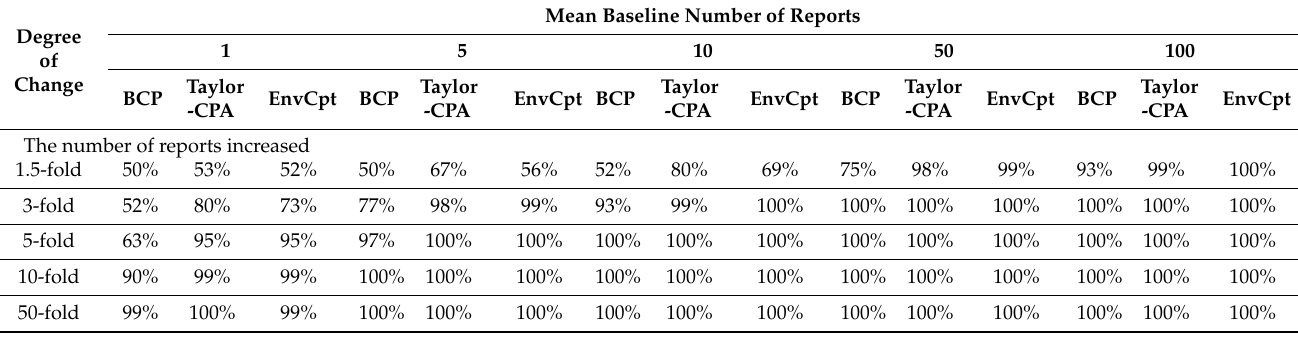
Table 1. Balanced accuracy of performance results obtained with the three change point analysis methods on the 1000 simu- lated datasets for 25